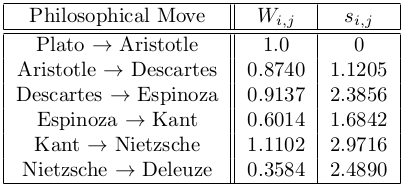
Table from the paper: Can the evolution of music be analyzed in a quantitative manner?
Table text:
PhilosophicalMove
W i,j
s i,j
Plato → Aristotle
1.0
0
Aristotle → Descartes
0.8740
1.1205
Descartes → Espinoza
0.9137
2.3856
Espinoza → Kant
0.6014
1.6842
Kant → Nietzsche
1.1102
2.9716
Nietzsche → Deleuze
0.3584
2.4890